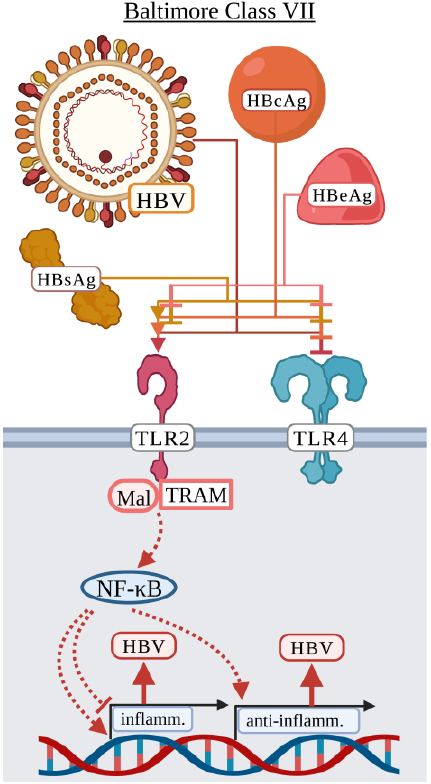
Figure 7. Baltimore Classification VII viruses recognized by surface TLRs: Baltimore Class VII includes hepatitis B virus (HBV). HBV ligands were agonistic and antagonistic including HBsAg, HBcAg, and HBeAg. HBsAg was found to both activate and inhibit TLR2 signaling and inhibit TLR4 signaling. HBcAg was found to activate TLR2 signaling and inhibit TLR4 signaling. HBeAg was shown to inhibit both TLR2 and TLR4 signaling by colocalizing with Mal and TRAM at the subcellular level.